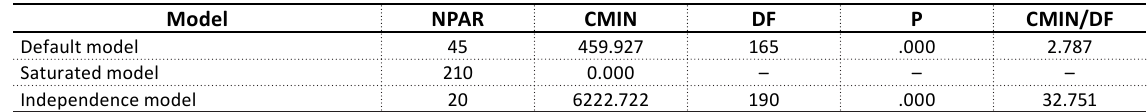
Table 4. Details of CMIN/DF